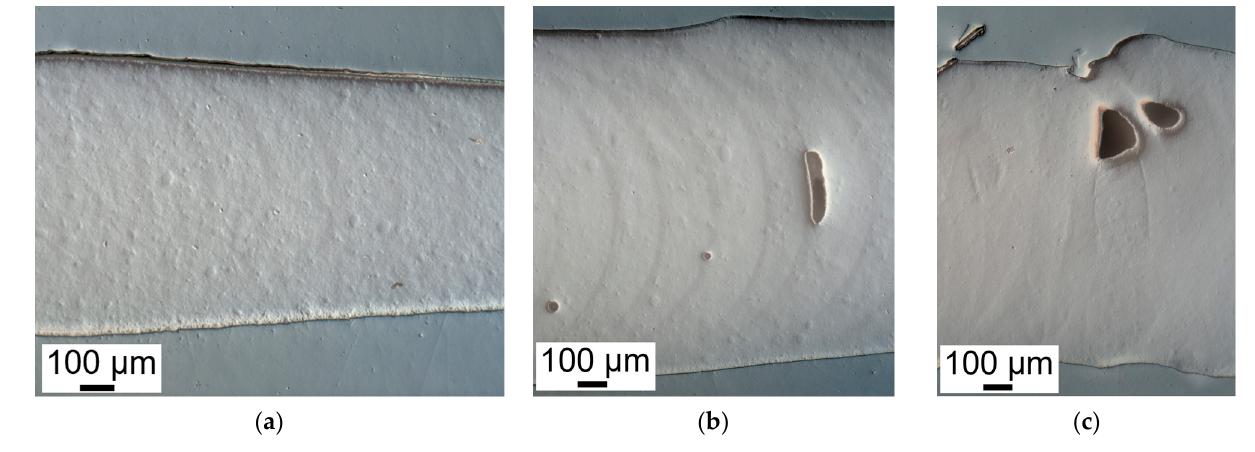
Figure 8. Darkfield microscope image of ( a ) 3%, ( b ) 5%, and ( c ) 7% FS.